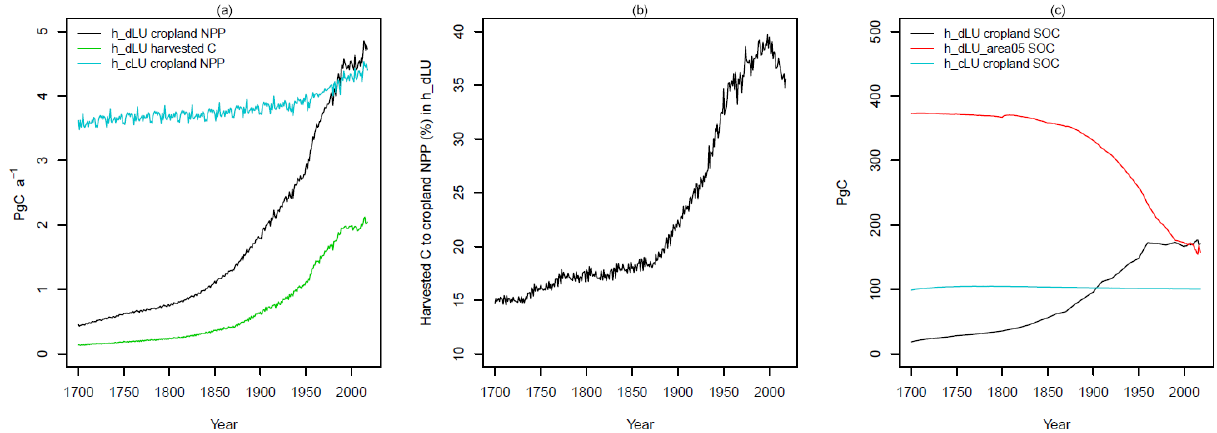
Figure 2. Plots for cropland NPP and harvested C (a) , percentage of harvested C to cropland NPP in h_dLU (b) and SOC for cropland stocks, and historical SOC losses from LUC (c) for the years 1700–2018 for simulations with transient land use (h_dLU), constant land use of 2005 (h_cLU), transient land use, and SOC development from land use change including cropland area and historical PNV area that will be converted until the year 2005